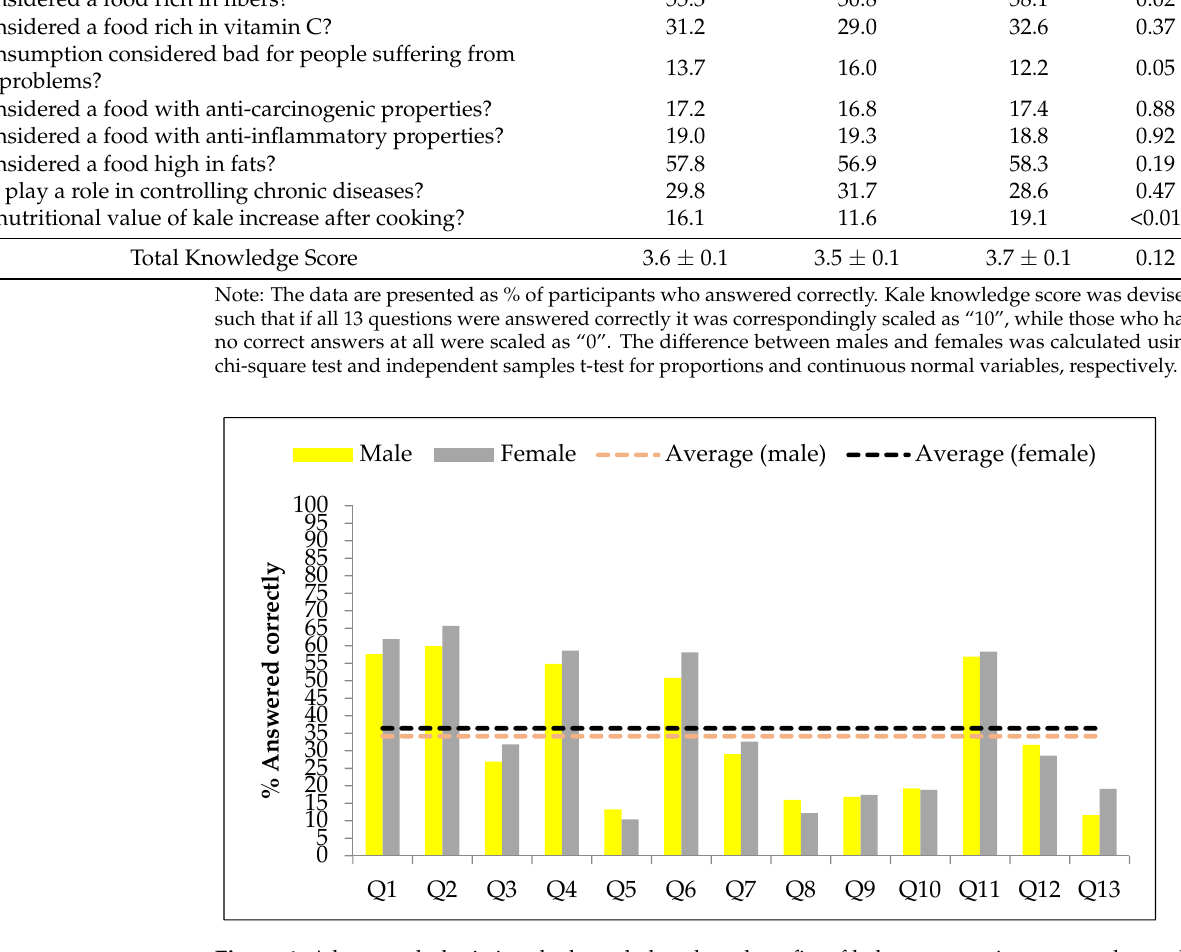
Table 2. Kale knowledge score for the study participants.